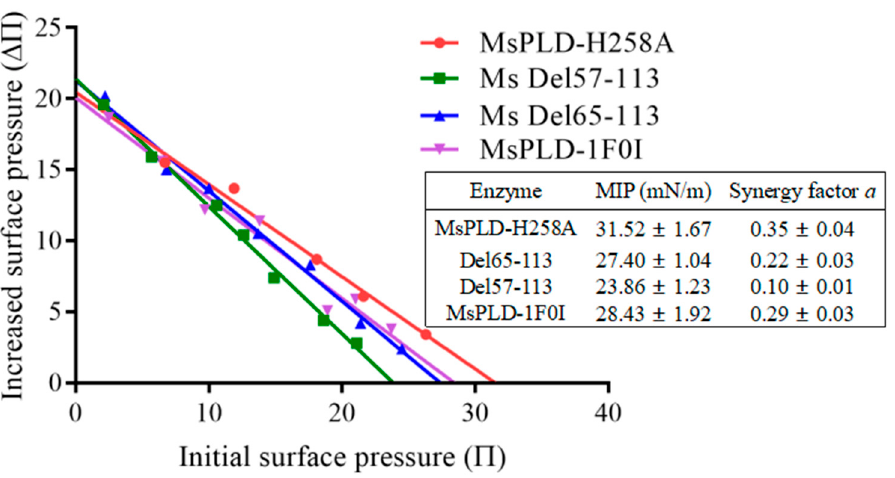
Figure 5. Interaction of wild-type MsPLD and its mutants with soy-PC monolayers. Maximal increase in surface pressure after injection of wild-type MsPLD or its mutants as a function of soy-PC monomolecular films that spread at various initial surface pressures. Maximum insertion pressure (MIP) and synergy factor a of wild type MsPLD and its mutants are shown in the table.